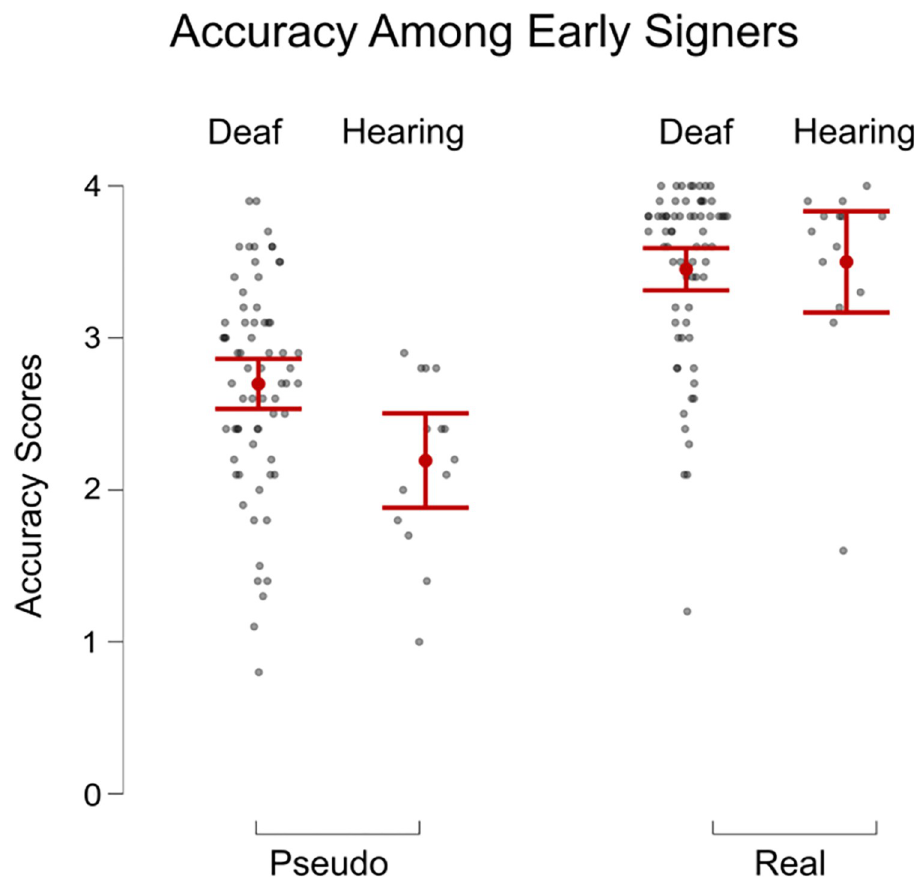
Fig 7. Accuracy scores of responses to pseudo names compared to real names between deaf and hearing groups who learned ASL at or before age 3. The error bars show standard error.